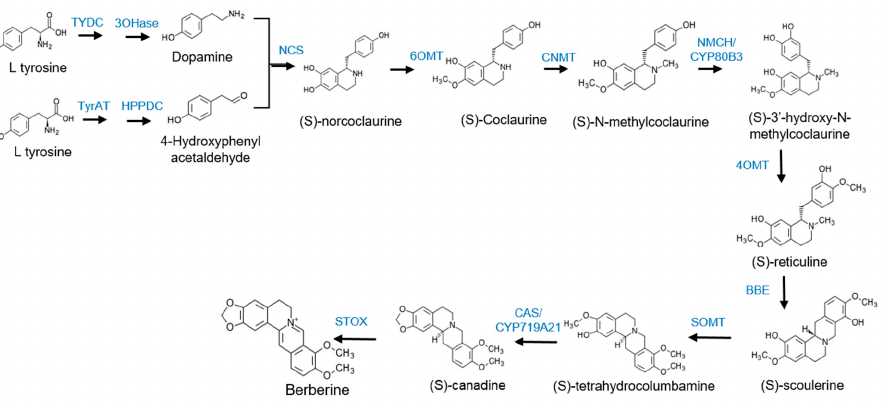
Figure 5. Berberine synthesis pathway. TYDC: tyrosine decarboxylase; 3OHase: tyrosine/tyramine